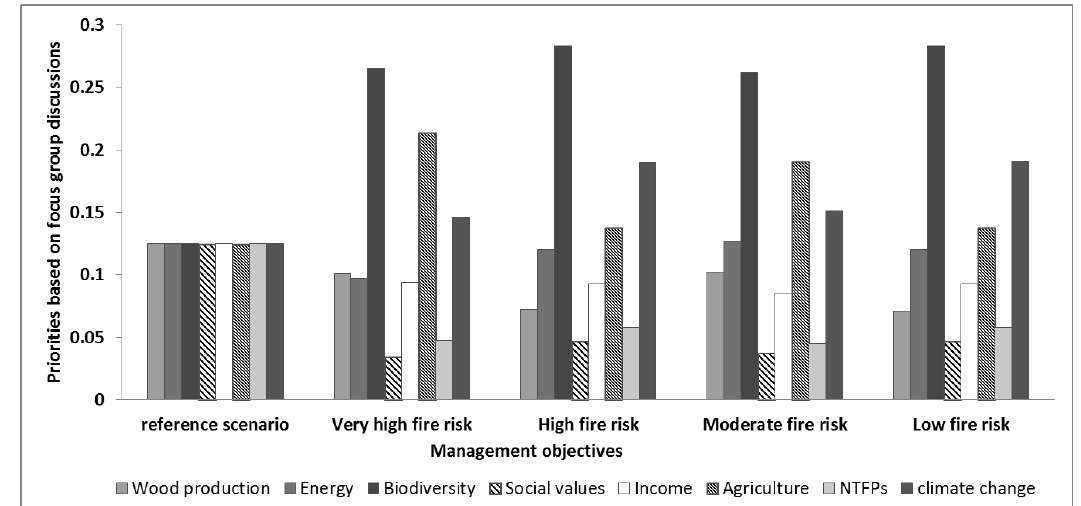
Figure 4. Priorities of management objectives according to the fire danger categories.